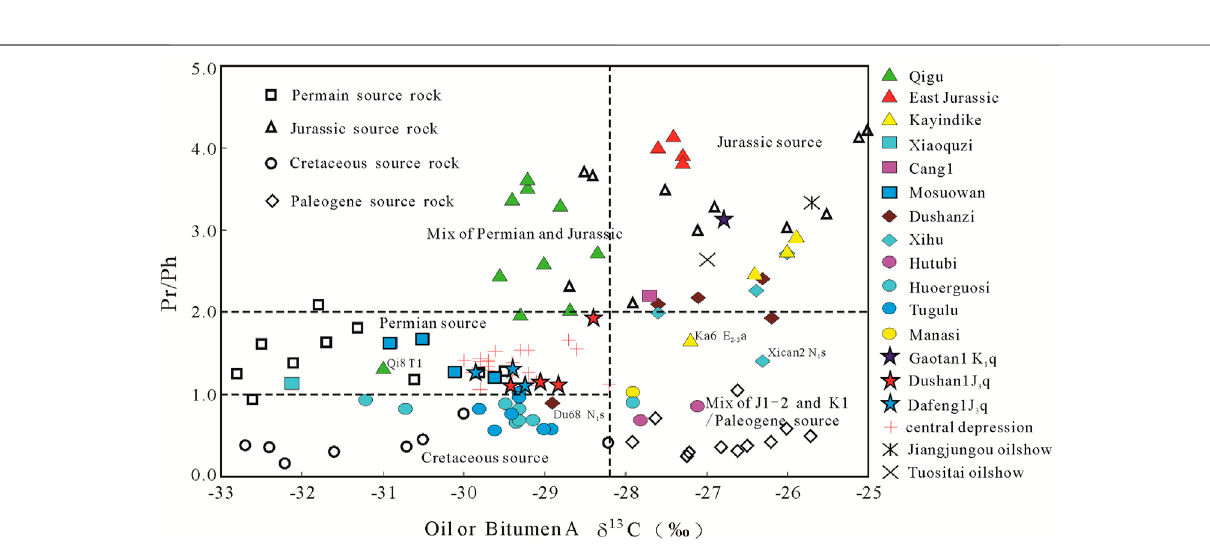
Frontiers in Earth Science |